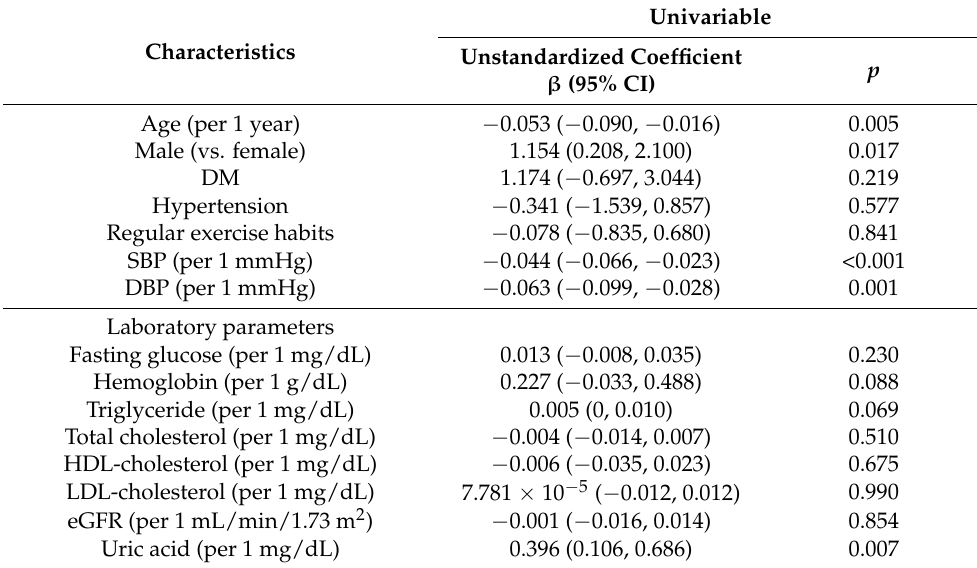
Table 2. Determinants for baseline FEV1/FVC using univariable linear regression analysis.